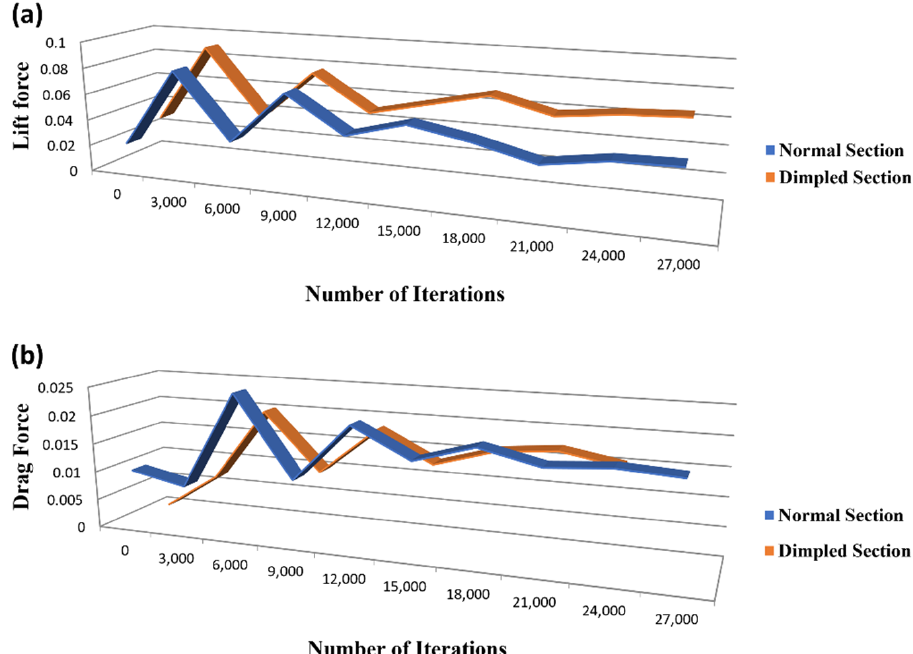
Figure 11. ( a ) Lift Convergence Plot. ( b ) Drag Convergence Plot.